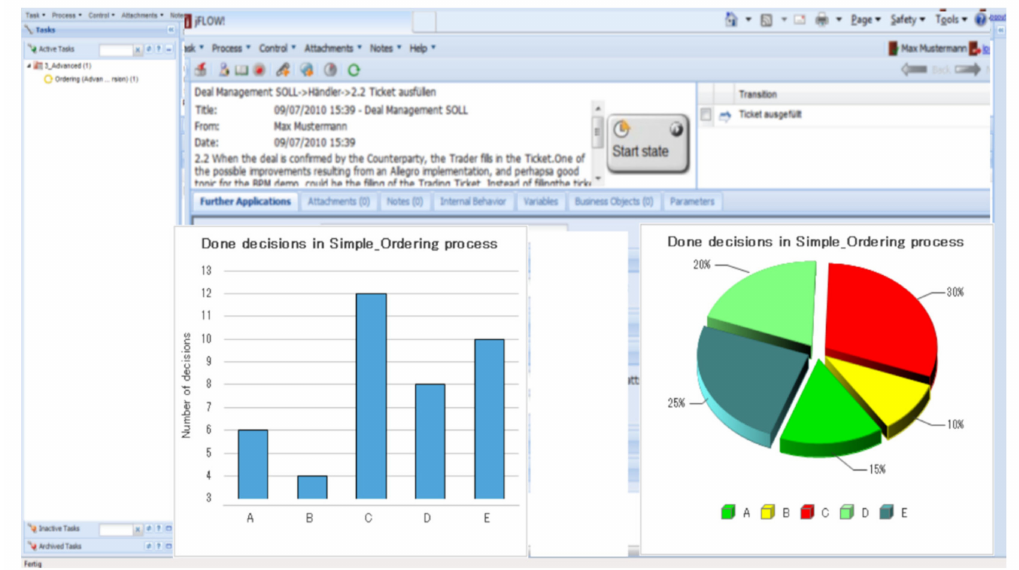
Figure 17. Business Analytics example for simple ordering (using